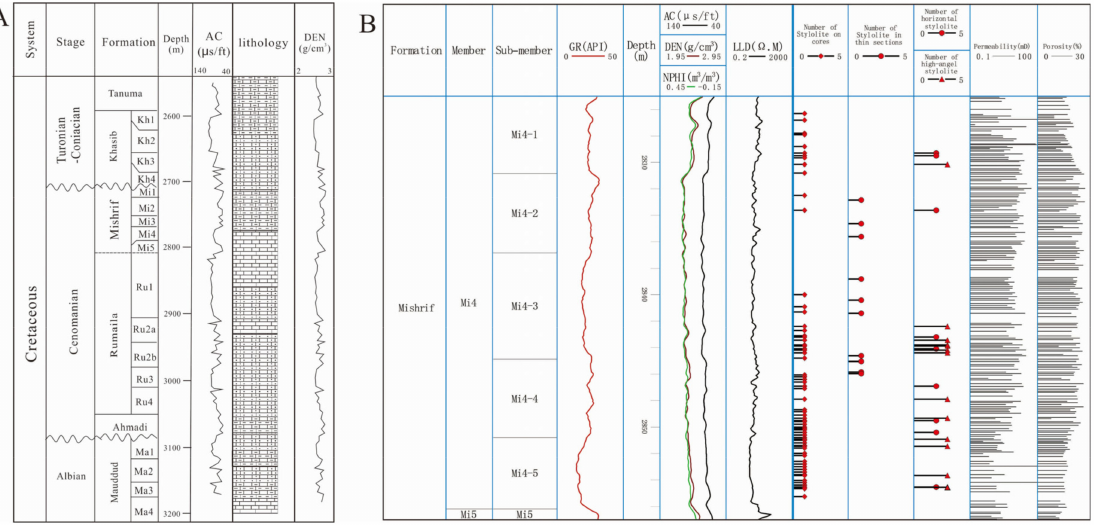
Figure 1. The stratigraphic column in the Ah Oilfield. ( A ) The stratigraphic column of Cretaceous; ( B ) The stratigraphic column of the Mi4 member of the Mishrif